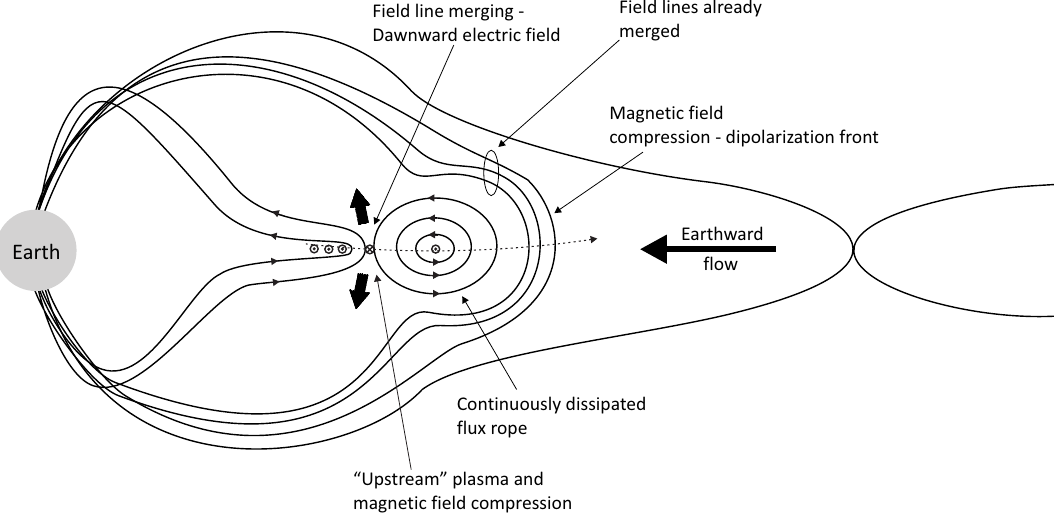
Fig. 8. A qualitative schematic diagram in XZ plane depicting our conceptual context according to our observations. The flux rope structures are formed due to multiple reconnection X-lines (MRX) in the near-tail, an idea first introduced by Slavin et al. (2003). The flux ropes are then being “trapped” inside closed magnetic field lines and accelerated earthward, presumably as a result of a combination of magnetic tension forces and plasma convection. Existence of a sequence of flux ropes propagating earthward is the likely case. Their dissipation would eventually result in multiple substorm onsets all contributing to the same major substorm phenomenon and final relaxation of the magnetotail into a dipolar configuration. Cross-tail current is disrupted by the magnetic field reconfiguration due to field line merging. Thick black arrows denote the presumed plasma outflow regions. Dashed arrow denotes the THEMIS spacecraft relative